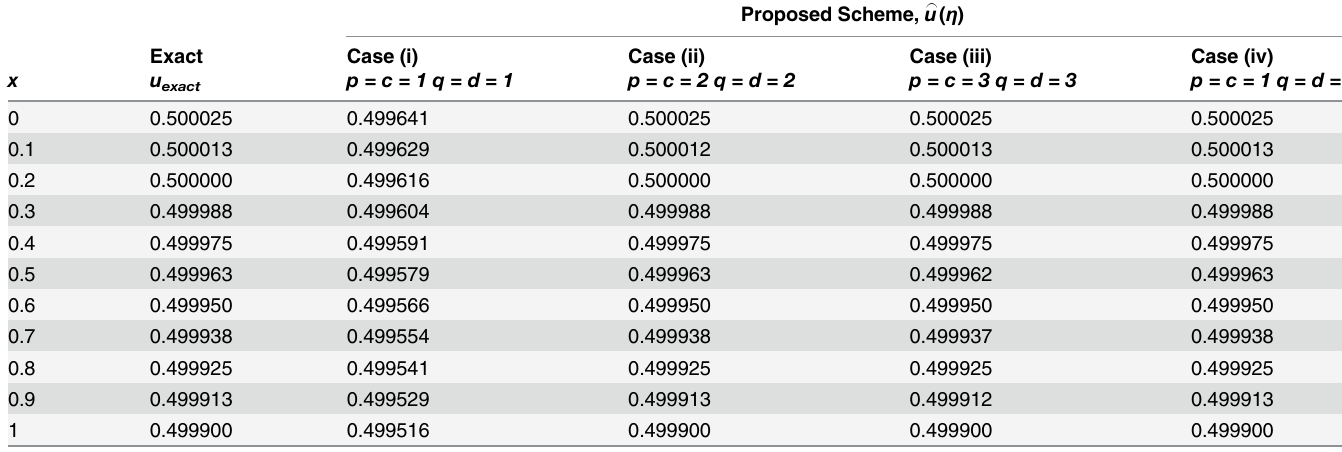
Table 14. Comparison of approximate solutions with different values of c and d at t = 0 . 1 .